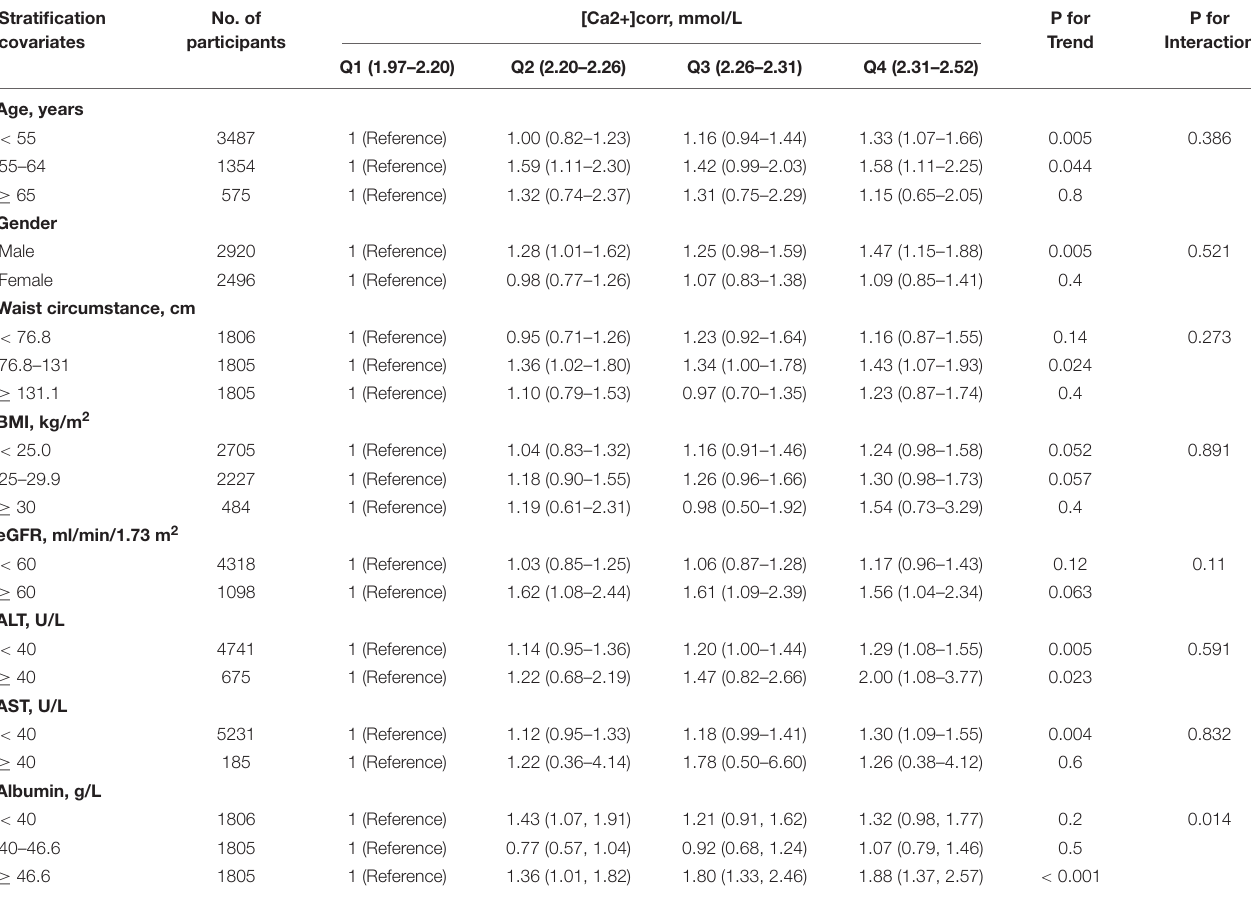
[Ca2+]corr, mmol/L